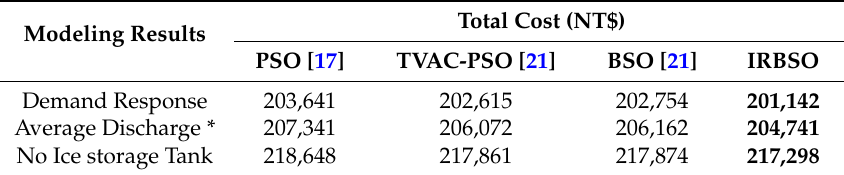
Table 4. The ice storage air conditioning with dynamic electricity price on a summer day (16 July